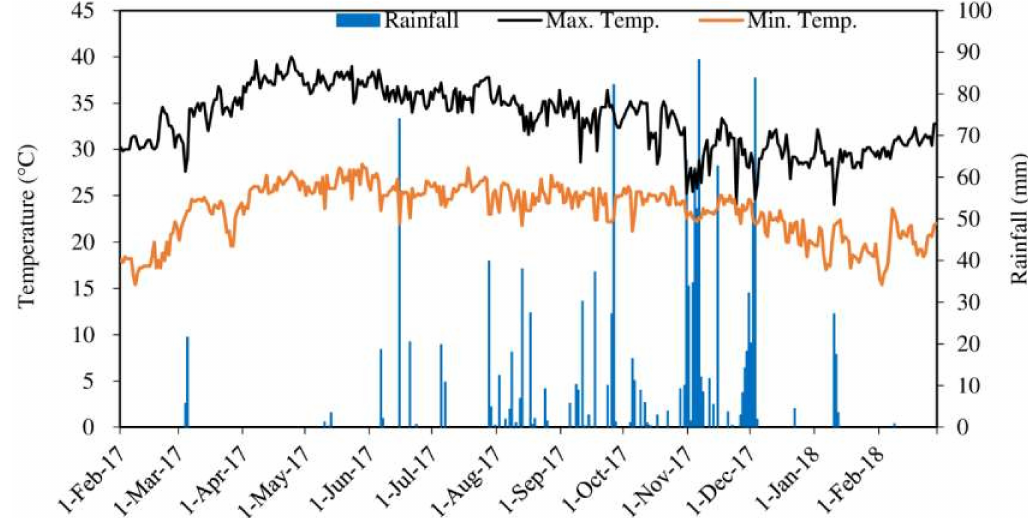
Figure 1. Daily rainfall, maximum and minimum temperature from February 2017 until February 2018 as measured at experimental site of Tamil Nadu Rice Research Institute, Aduthurai, Tamil Nadu,